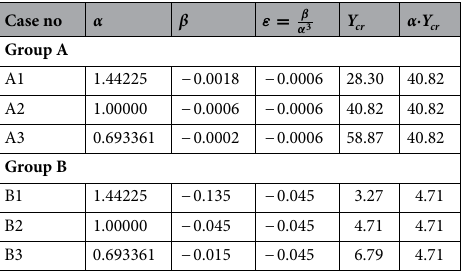
Table 1. Coefficients of the Duffing equation that were tested during research (softening systems).